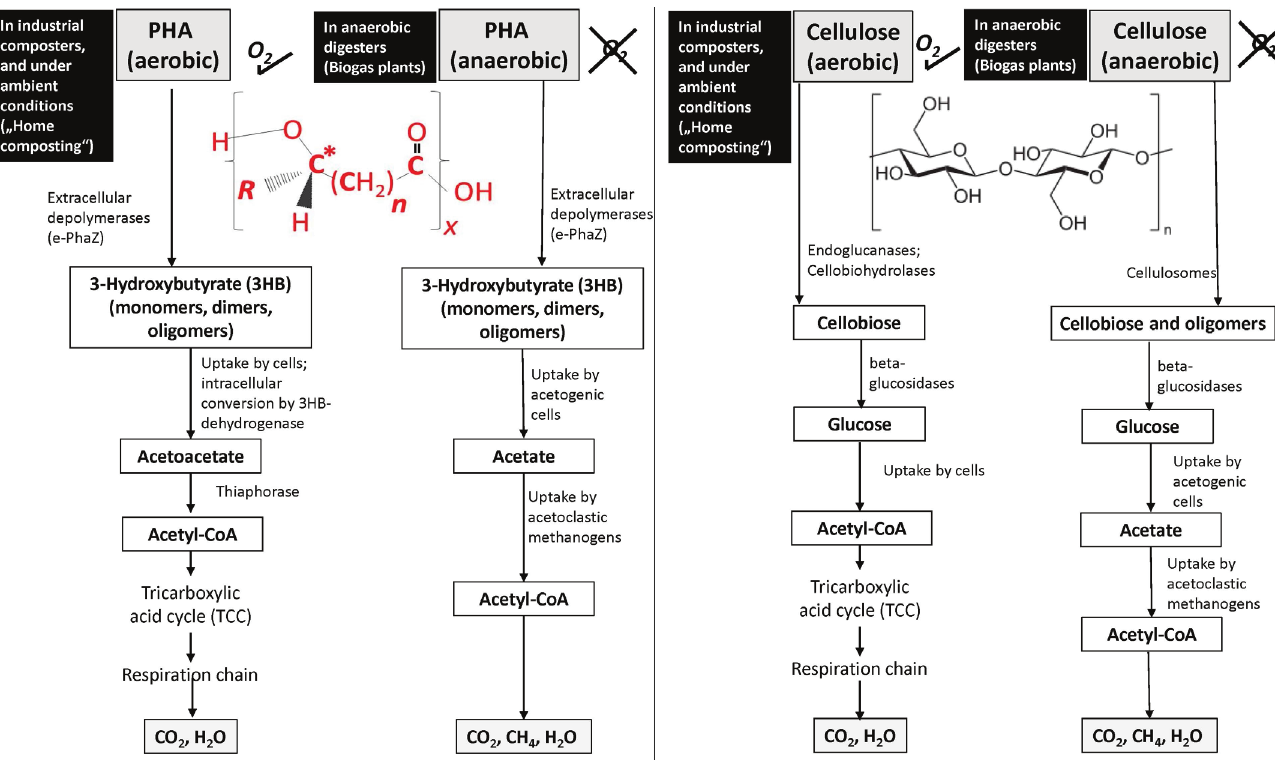
Fig. 2 – Comparison of biodegradation of PHA and cellulose under aerobic (industrial and home composting) and anaerobic (bio- gas plant)